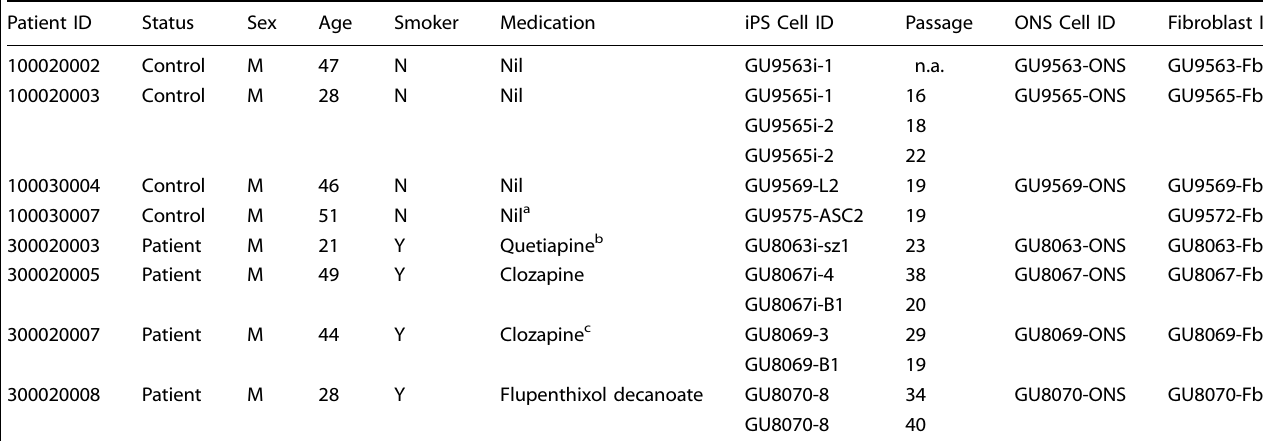
Table 3. Participants and cell